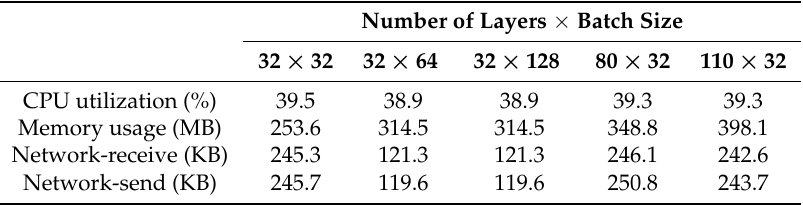
Table 3. Hardware resources by number of layers and batch size.